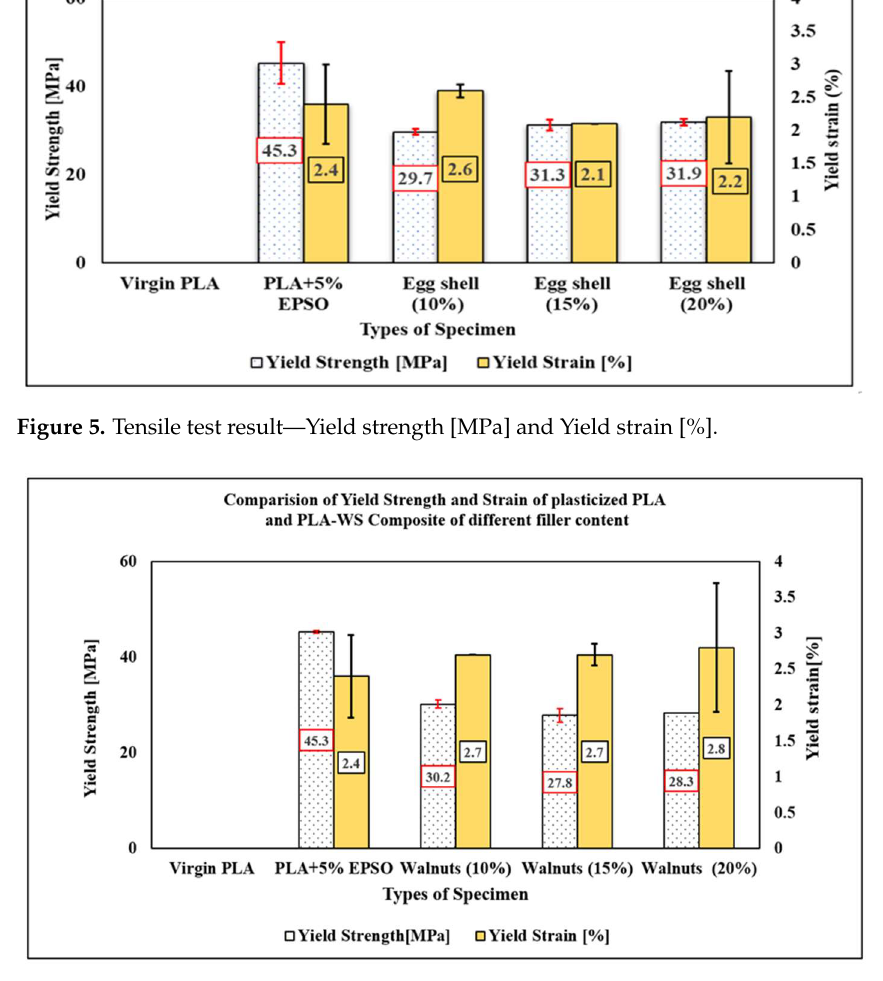
Figure 6. Tensile test result—Yield strength [MPa] and Yield strain [%].